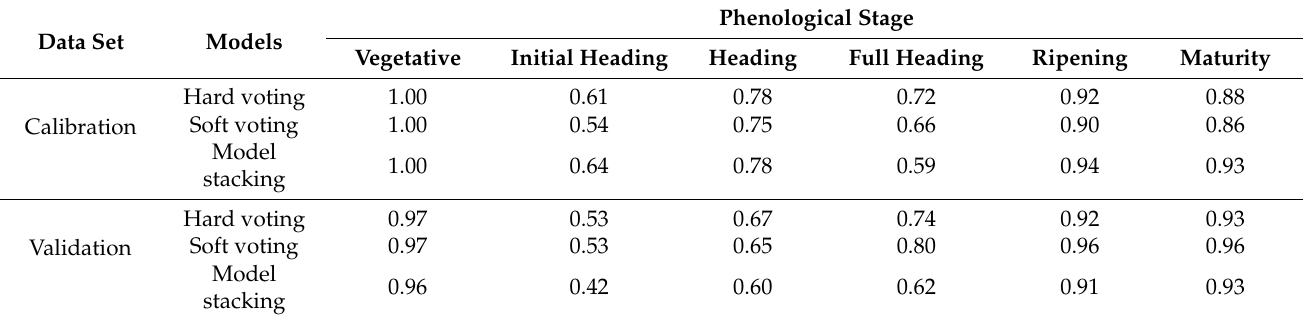
Table 4. The F1-scores in different ensemble models for detecting phenology in calibration and validation datasets. Data